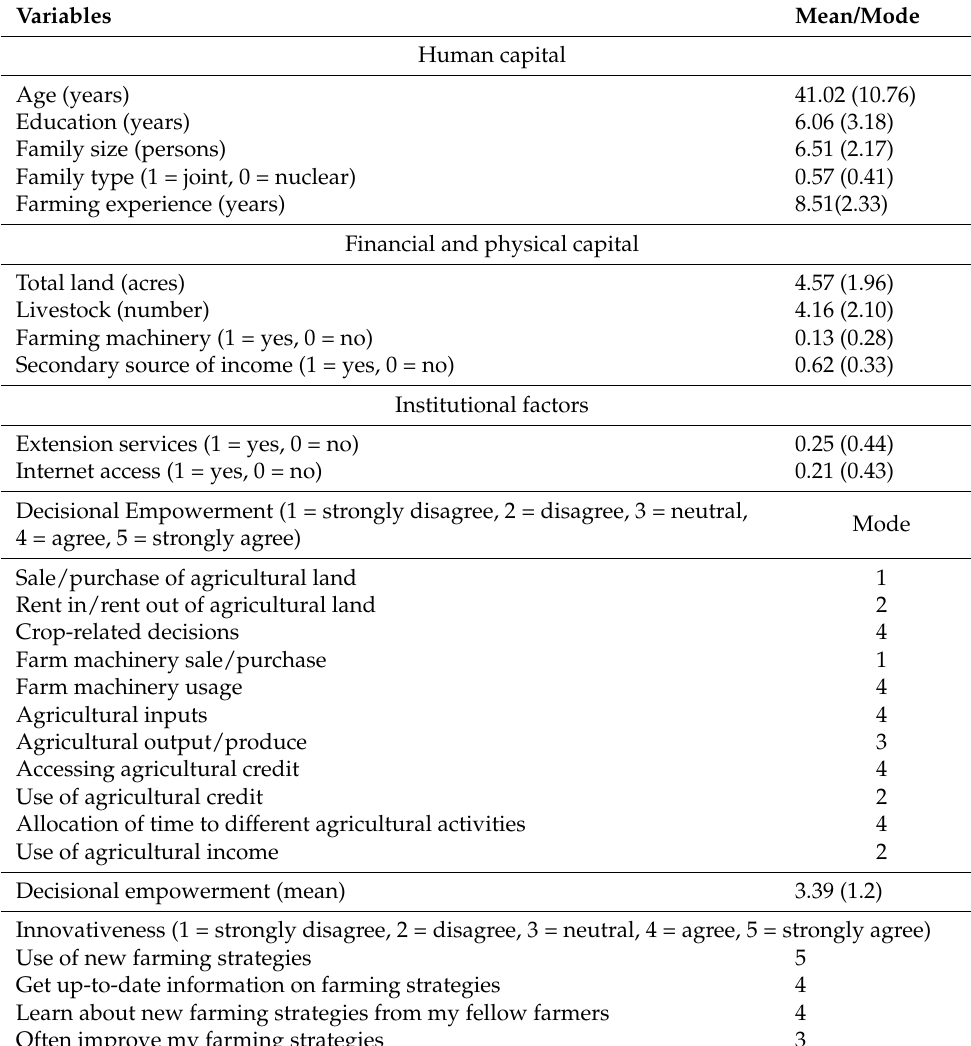
Table 2. Sample background, decisional empowerment, and innovativeness